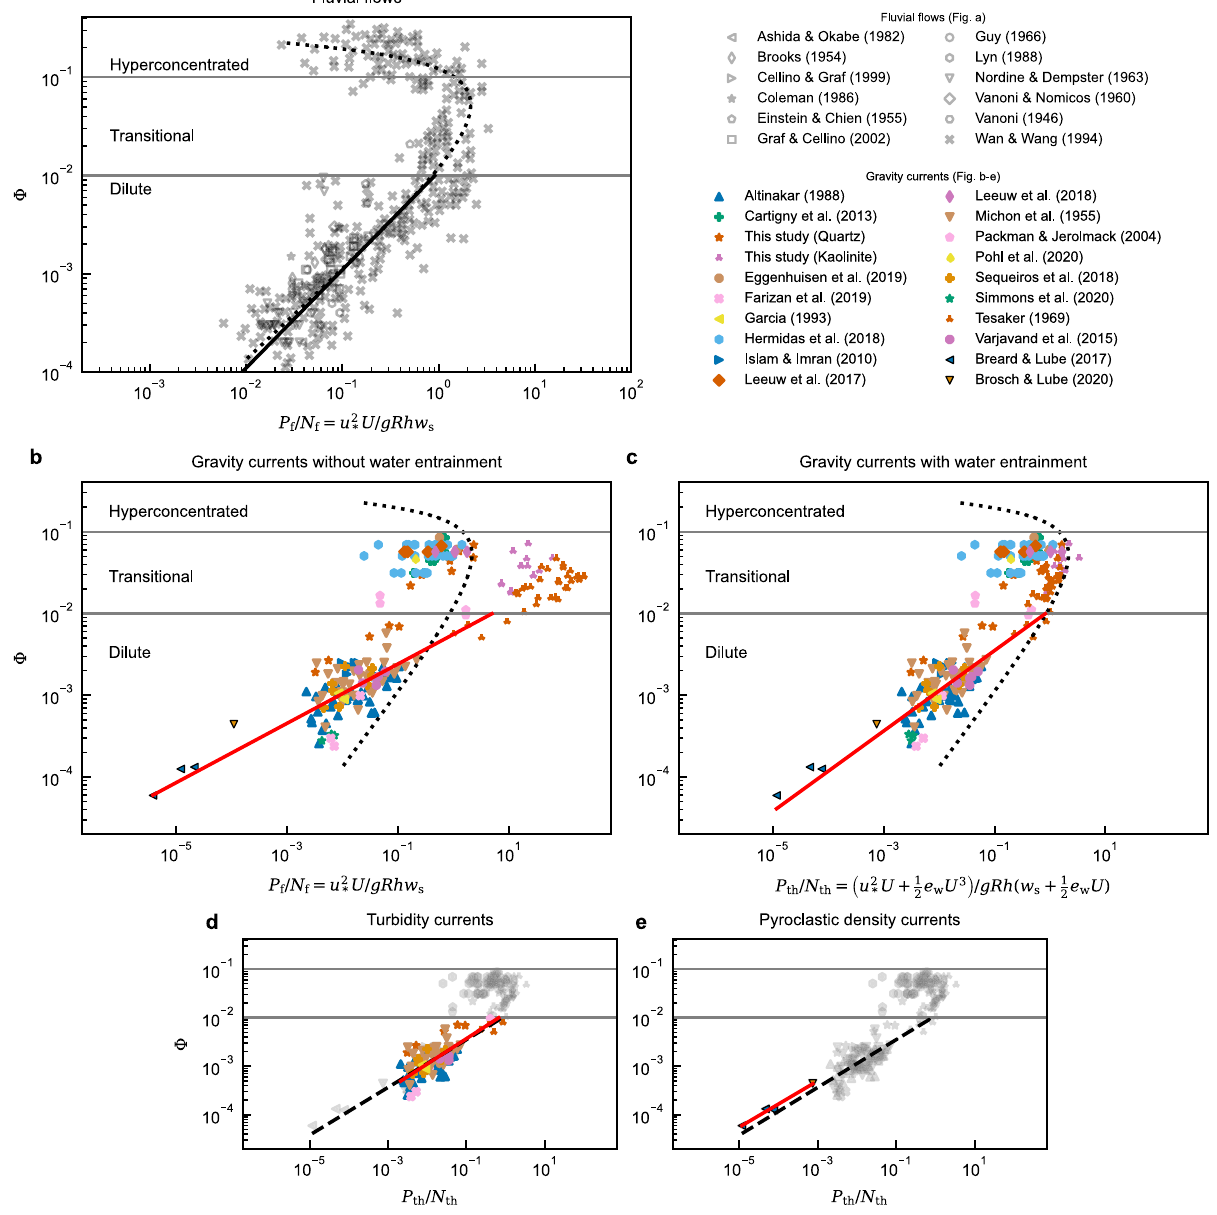
Fig. 3 | Sediment transport capacity for fl uvial fl ows and gravity currents. Sediment concentration, Φ , versus dimensionless fl ow power, P ~ / N ~ for: a fl uvial data (see supplementary material for the detailed reference of each source) with the log-law model, P f / N f ; b all gravity current data with the log-law model; c all gravitycurrentdatawiththetop-hat,entrainmentbased,model, P th / N th ; d turbidity current concentration with the top-hat model; and e pyroclastic density current concentration with the top-hat model. Dilute, transitional and hyperconcentrated